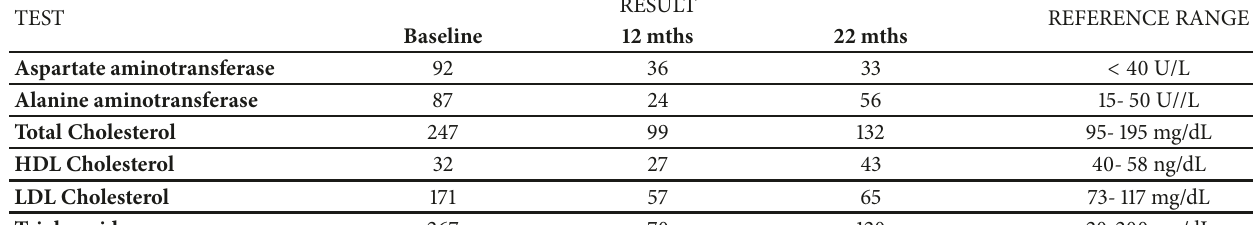
Table 1: Some of the patient’s lab tests with reference to growth hormone start.